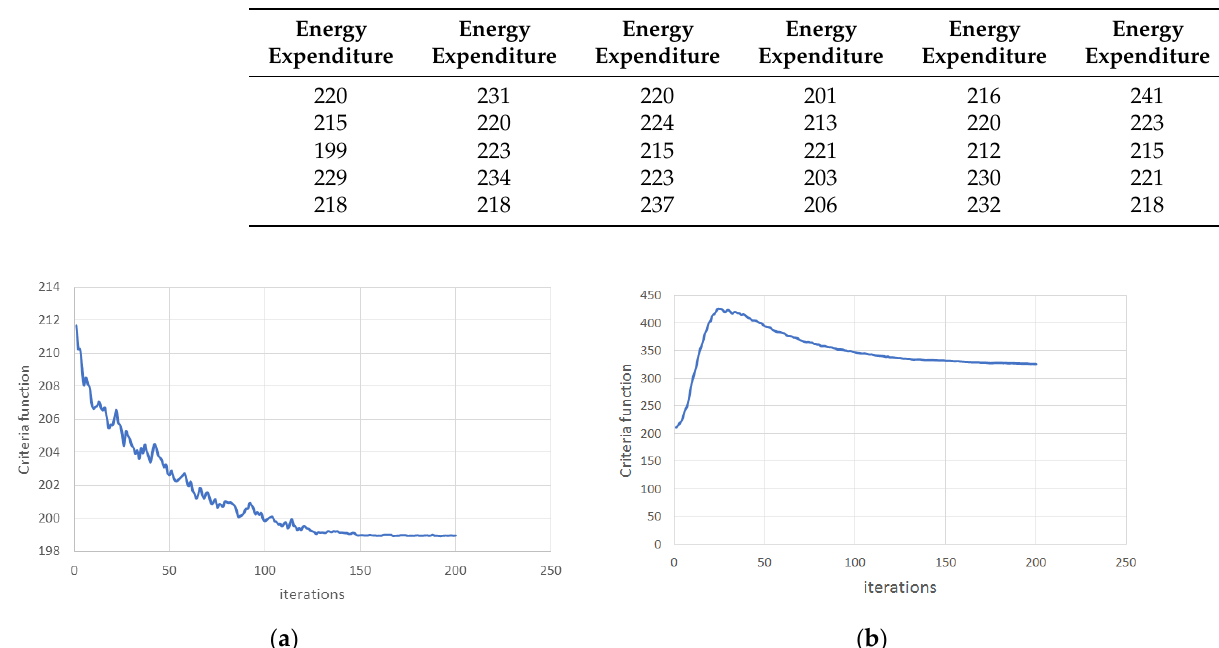
Table 12. Exemplary results of the genetic algorithm [kWh].